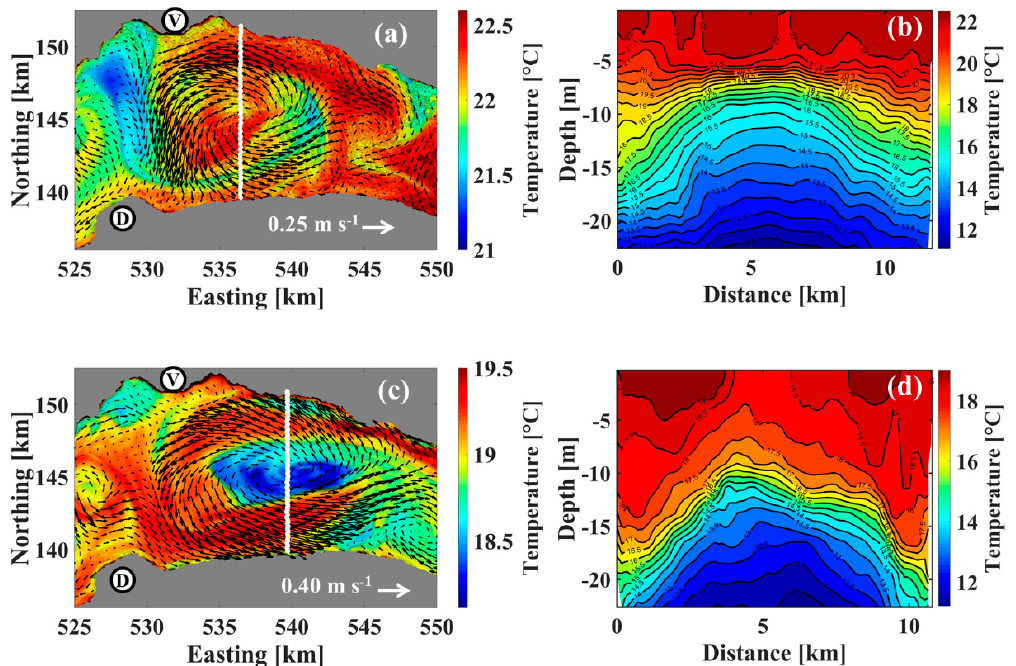
Figure 9. ( a ) Simulated temperature and current (0.3 m depth), and ( b ) simulated temperature profile along the white transect in ( a ) from the high-resolution, 3D numerical simulation for 21 July 2018 at 17:00 UTC. ( c ) Simulated temperature and current (0.3 m depth), and ( d ) simulated temperature profile along the white transect in ( c ) from the 3D numerical simulation for 21 September 2019 at 17:00 UTC. In ( a , c ), colors: temperature; colorbar legend: temperature range and arrows: currents; reference arrow in legend. V and D: reference points marked in Figure 1. In ( b , d ), zero on the x -axis is at the southern end of the transect; colorbar legend: temperature range.